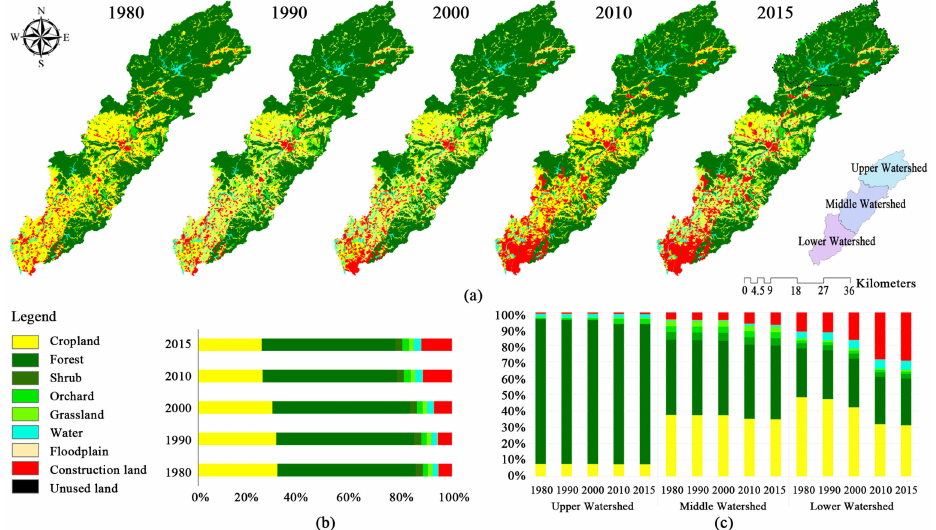
Figure 2. The types of land use in the LXH (1980–2015) ( a ) Spatial distribution of land use; ( b ) Percent coverage of the land use types; and ( c ) percent coverage of the land use types in the upper, middle and lower watershed of the river